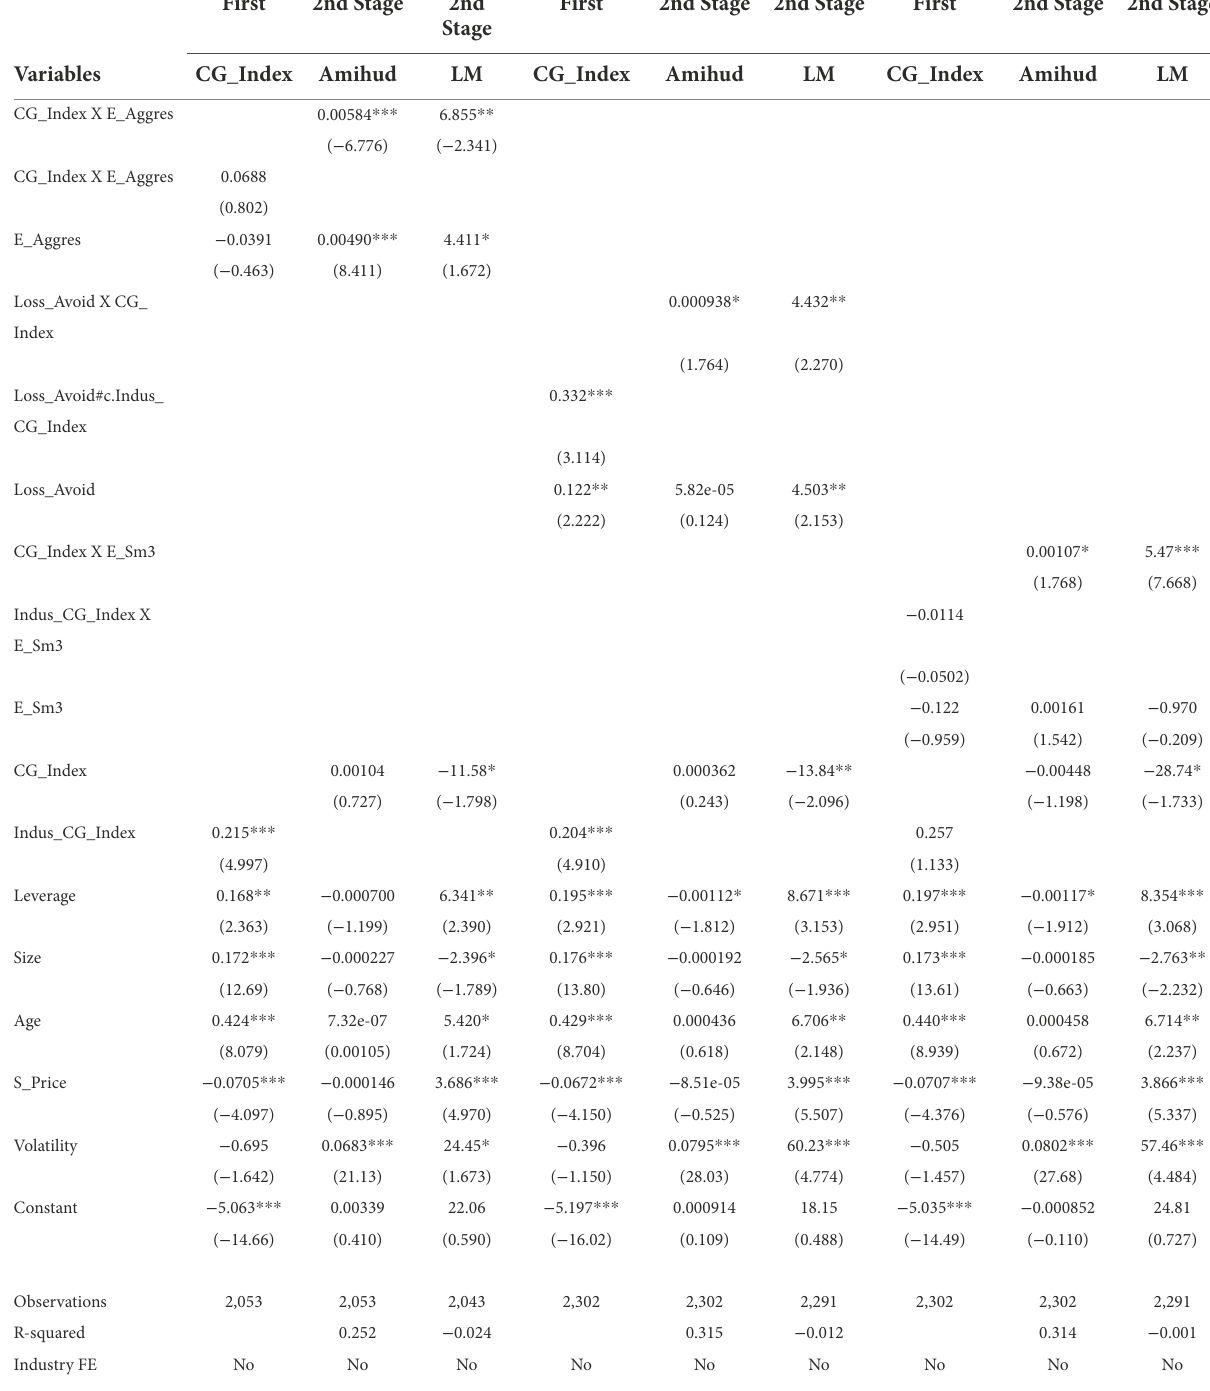
TABLE 14 CG_index, financial transparency and stock liquidity (2SLS